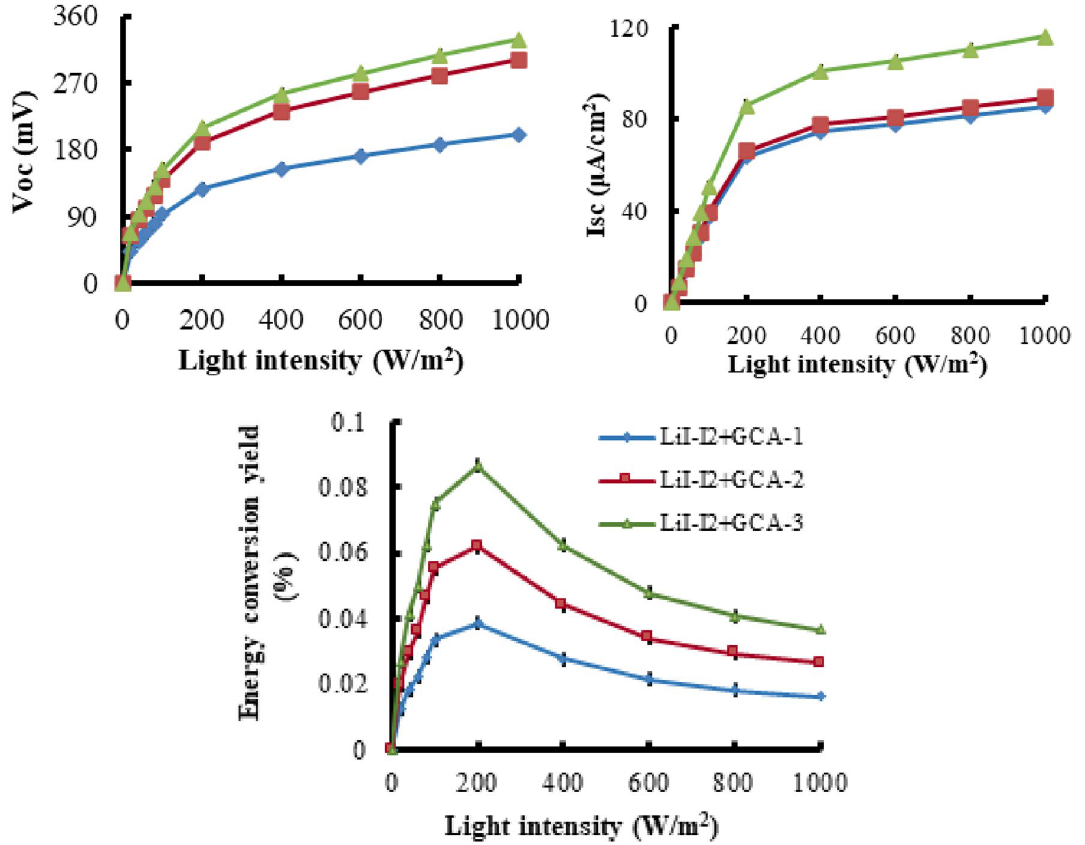
Fig. 7 Parameters affecting the performance of the DSSCs using the LiI-I